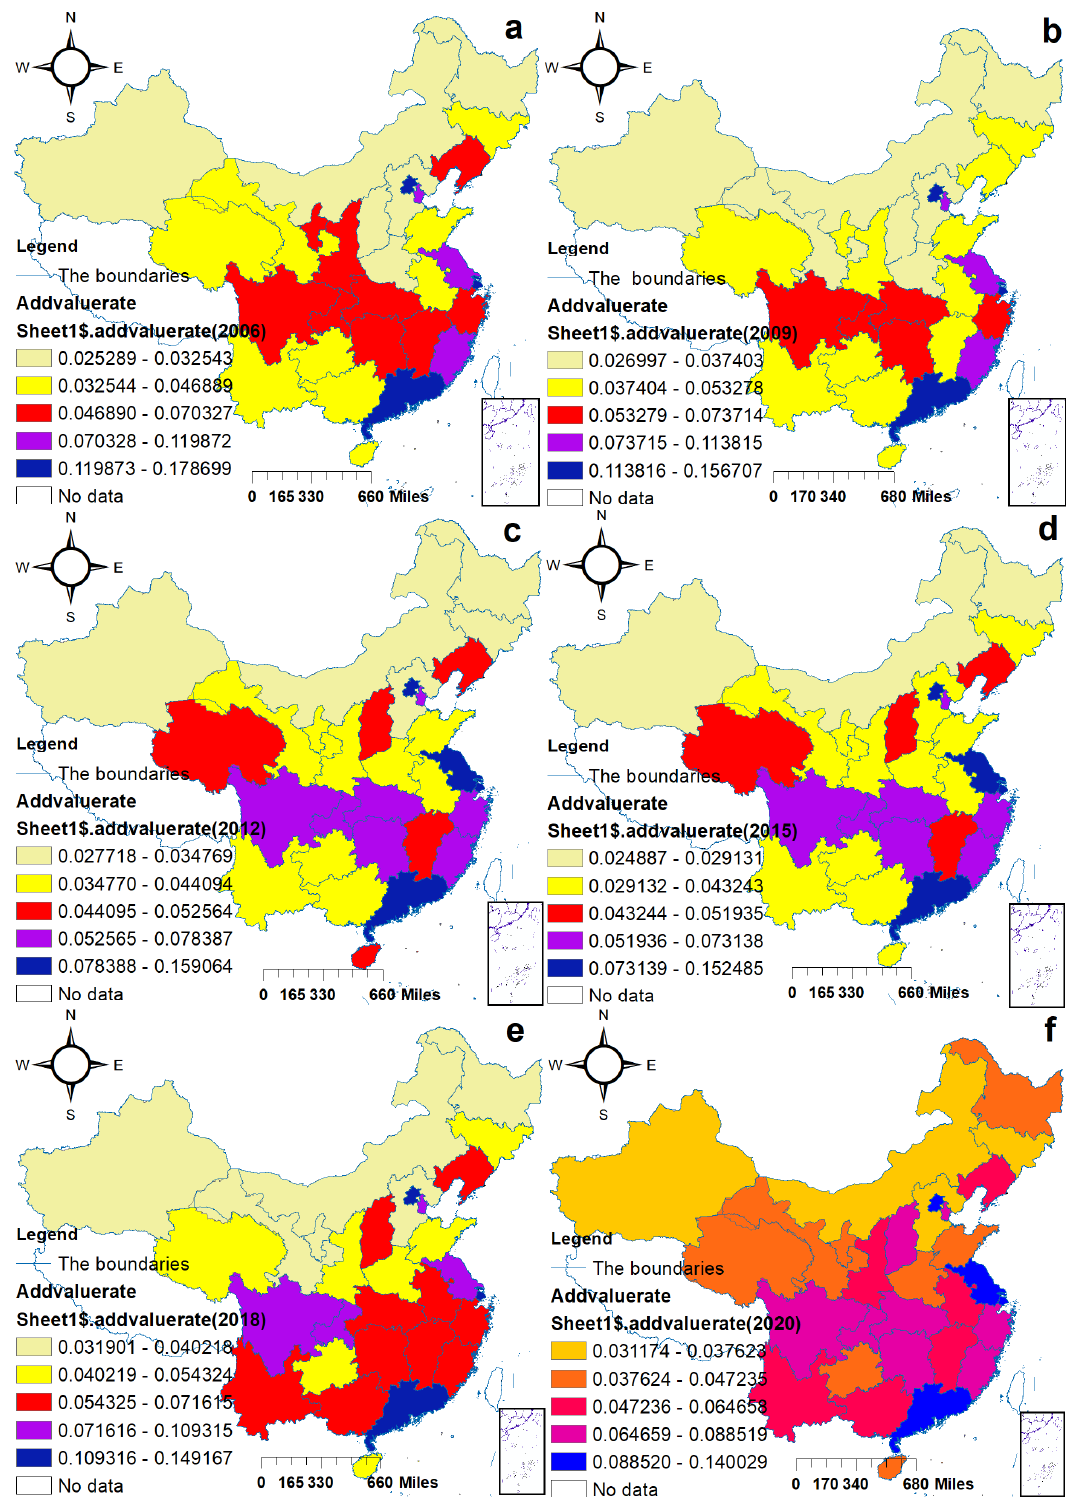
Figure 3. Spatial evolution characteristics of digital industrialization. Notes: Figures ( a ), ( b ), ( c ), ( d ), ( e ) and ( f ) represent the level of digital industrialization ( addvaluerate ) in 2006, 2009, 2012, 2015, 2018 and 2020, respectively. The figures were created by the author using ArcGis 10.8.